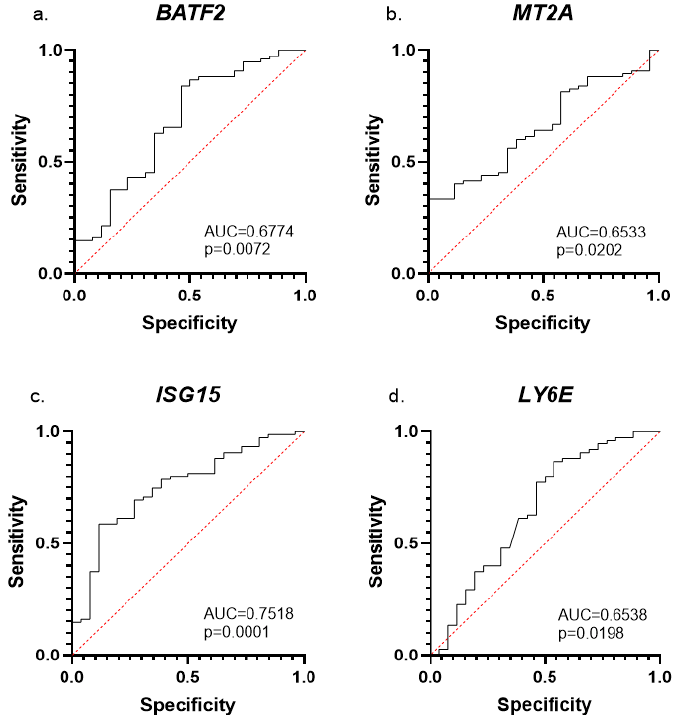
Figure 1. ROC analysis of ASD-specific mRNA expression biomarkers . AUC and p -values are displayed for ( a ) BATF2 , ( b ) MT2A , ( c ) ISG15, and ( d ) LY6E .